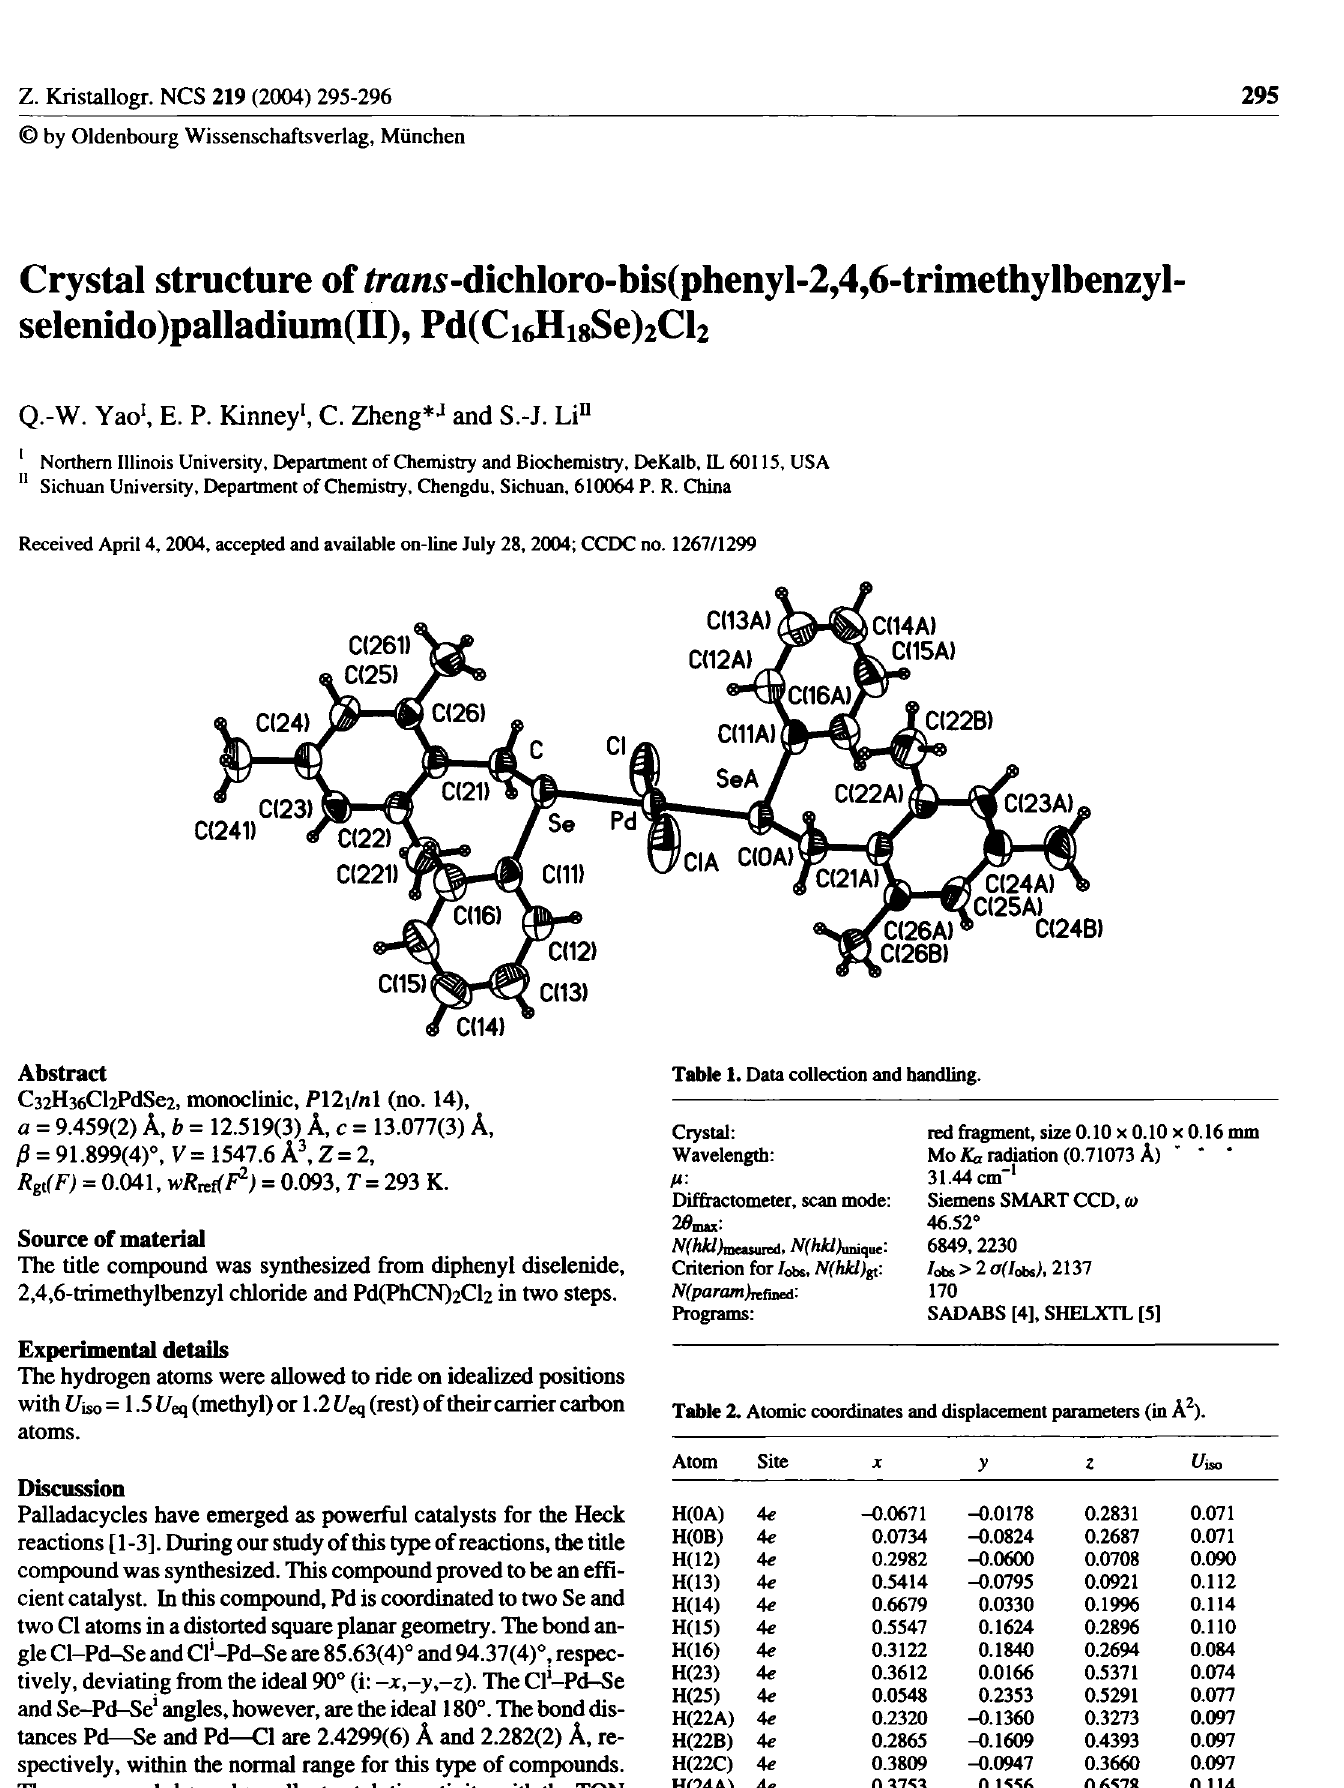
Table 2. Atomic coordinates and displacement parameters (in A 2